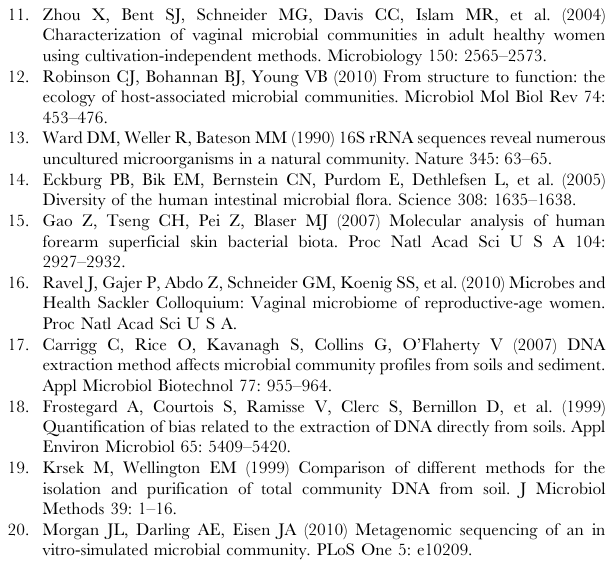
Figure S1 Combinations of species and enzymatic lysis